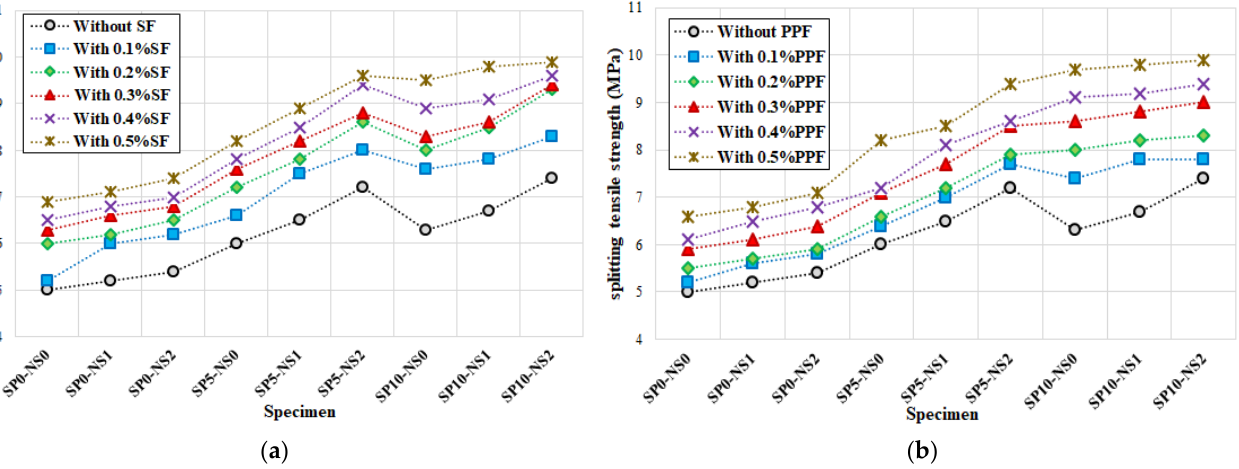
Figure 10. Influence of fibres of the splitting tensile strength of HSC ( a ) SF and ( b ) PPF.